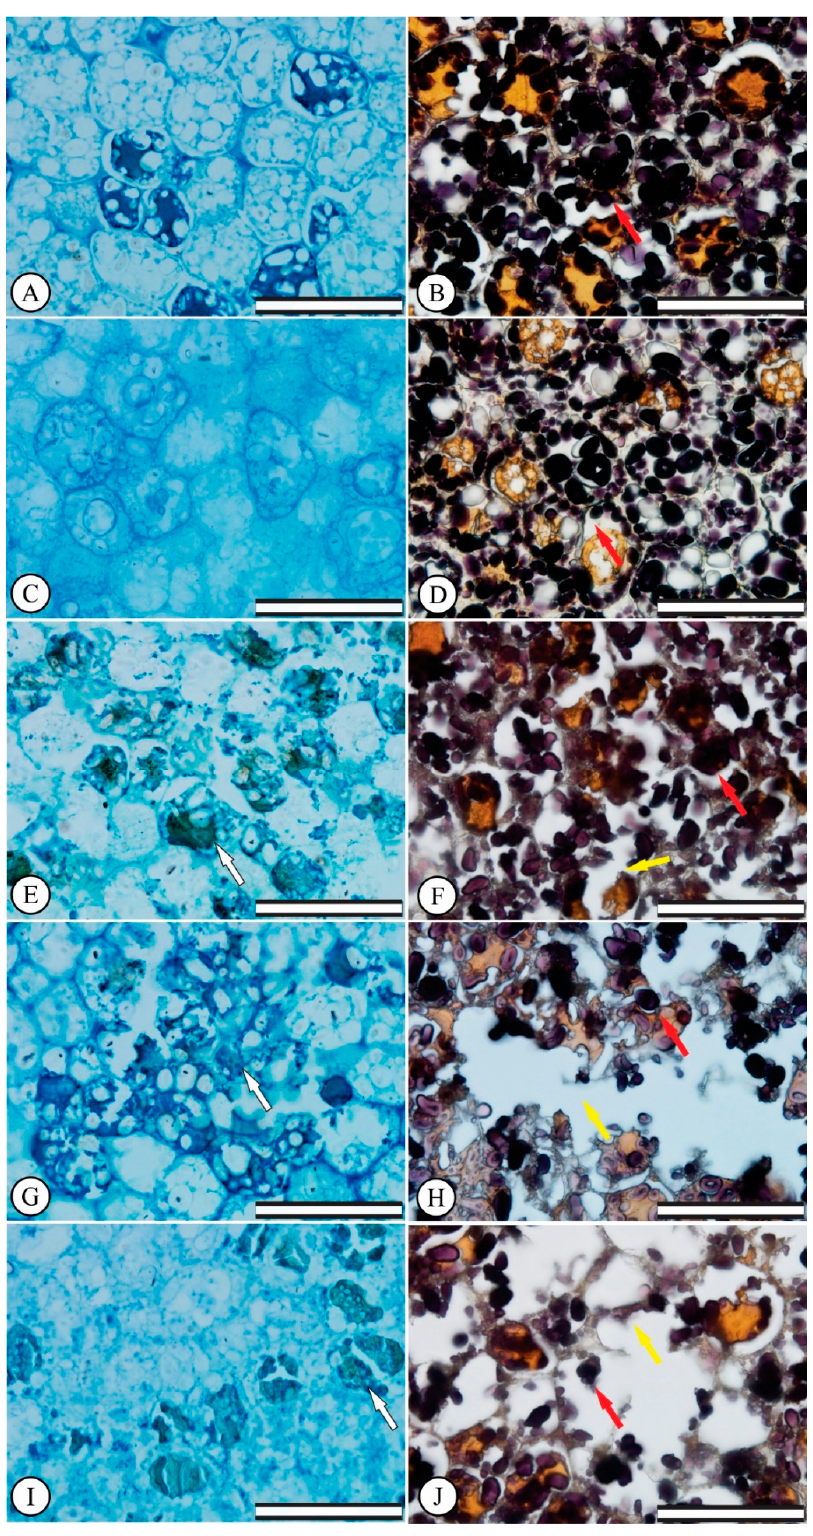
Figure 1. Eugenia dysenterica seed endosperms after the germination test. ( A , B ) control treatment, ( C , D ) 200 μ mol L − 1 Al 3+ , ( E , F ) 400 μ mol L − 1 Al 3+ , ( G , H ) 600 μ mol L − 1 Al 3+ , ( I – J ) 800 μ mol L − 1 Al 3+ . White arrows indicate phenolic compound production, red arrows indicate starch accumulation and yellow arrows indicate cell disruption. (First column) Scale bar 50 μ m. (Second column) Scale bar 100 μ m.